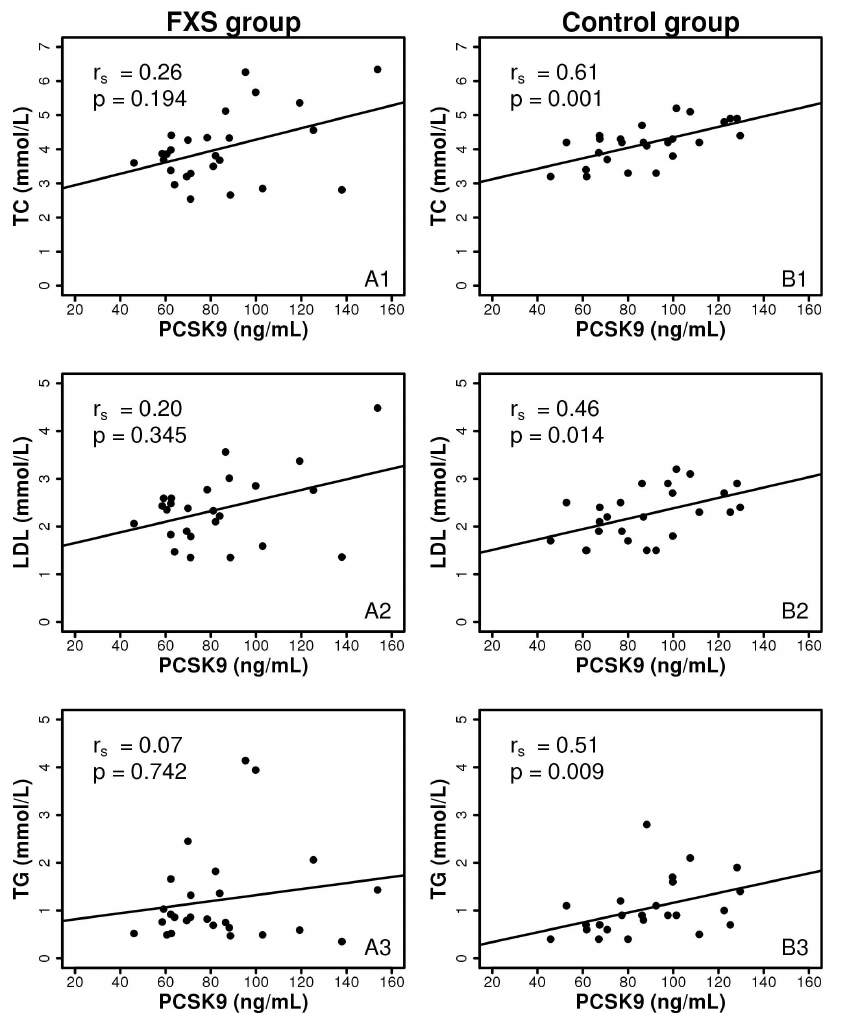
Fig 2. Correlation between PCSK9 levels and lipid parameters. Spearman correlations:betweenPCSK9 and total cholesterolin FXS group (A1) and control group (B1); betweenPCSK9 and LDL in FXS group (A2) and control group (B2); betweenPCSK9 and triglyceridesin FXS group (A3) and control group (B3). TC: total cholesterol; TG: triglycerides.